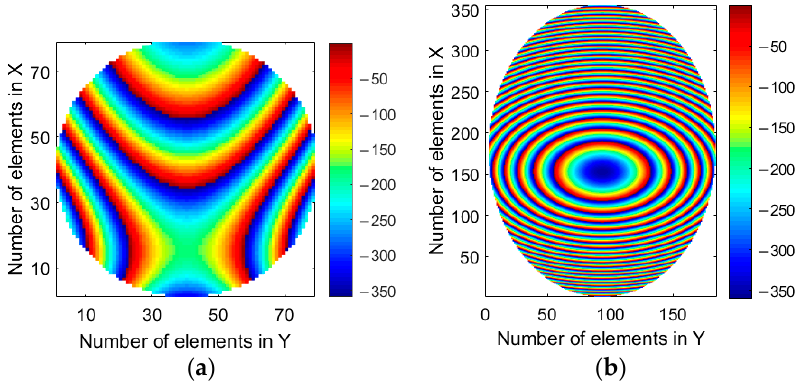
Figure 5. Bifocal phase distributions (in degrees) on ( a ) the sub-RA and ( b ) the main-RA.